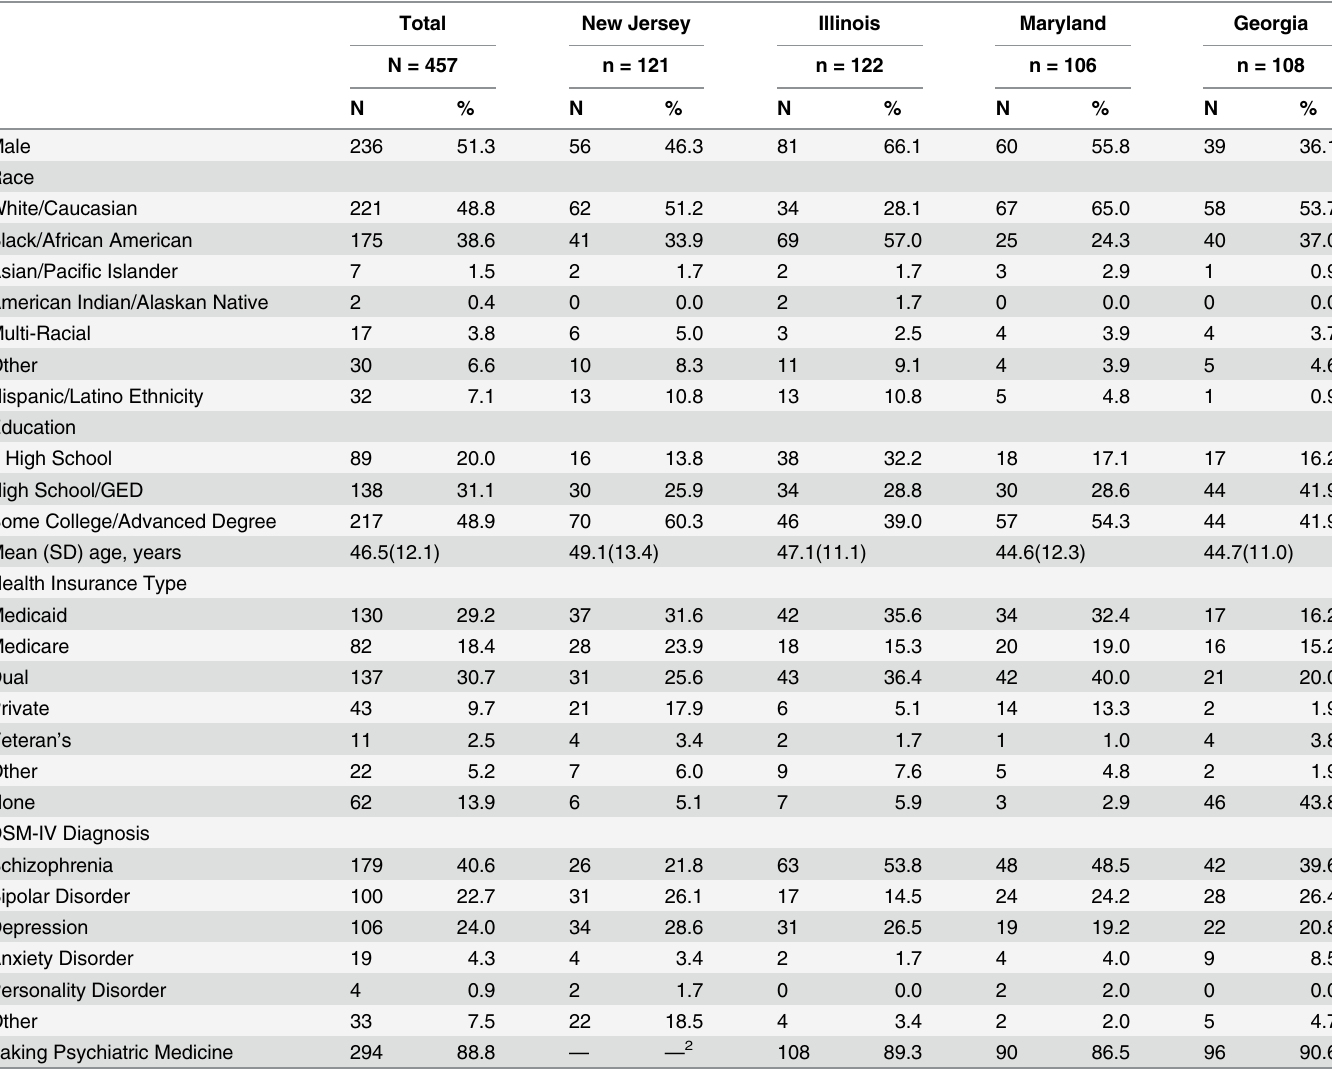
Table 1. Characteristics of adults with serious mental illnesses screened for common health conditions by U.S. state and total (N = 457) 1